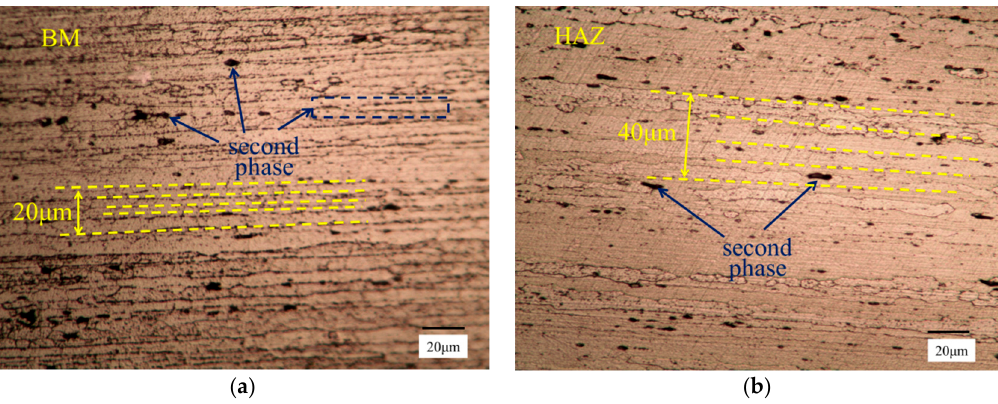
Figure 4. 6082 microstructure of T-welded joint of aluminum alloy: ( a ) base material (BM); and, ( b ) heat-affected zone (HAZ).